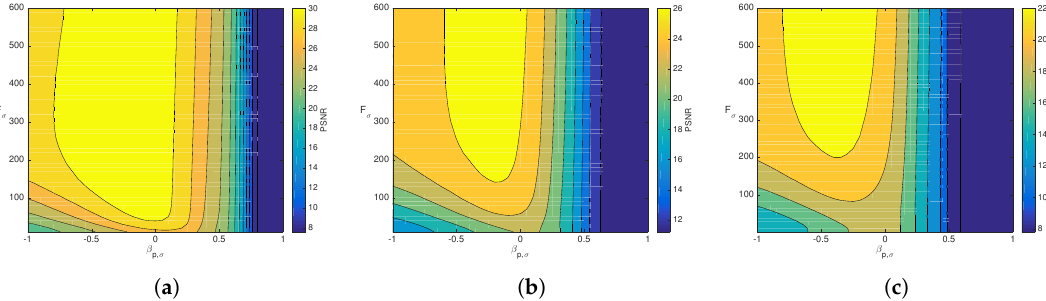
Figure 3. Surface plots of the dependency of the PSNR measure on the variables F σ and β p , σ . Lena deteriorated with Gaussian σ and impulse noise p . ( a ) σ = 10, p = 0.1. ( b ) σ = 20, p = 0.2. ( c ) σ = 30, p = 0.3.